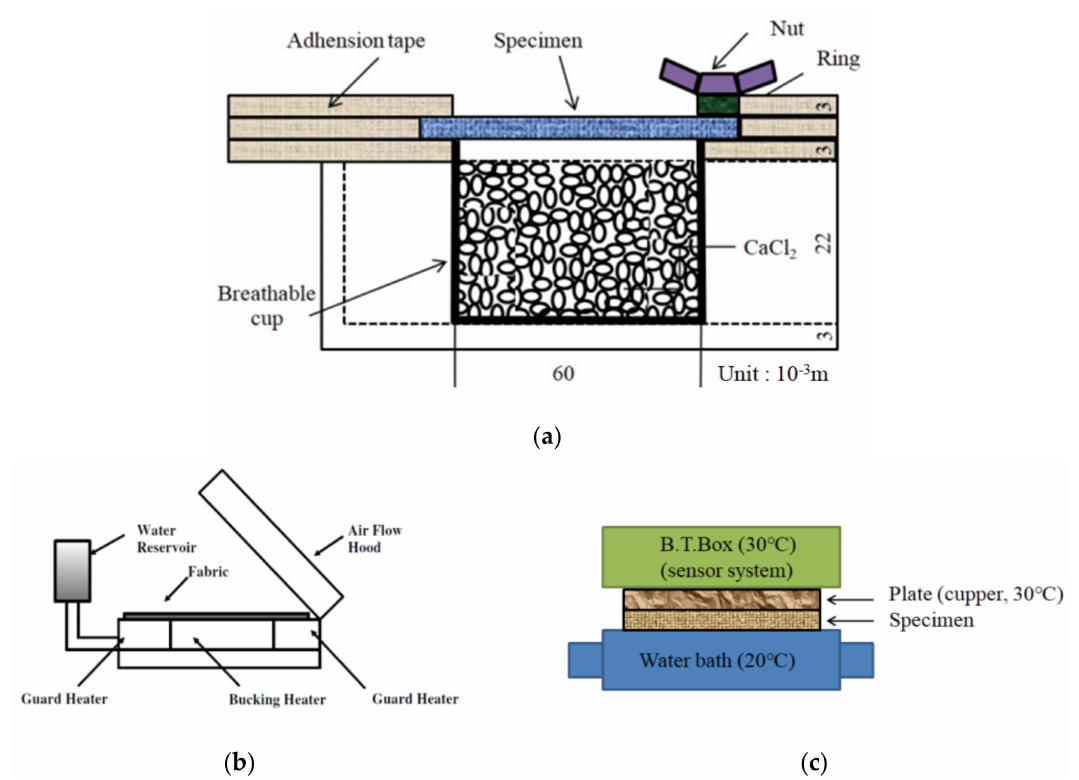
Figure 2. Schematic diagram of the measuring equipment of ( a ) upright cup method (JIS L 1099A-1), ( b ) sweating guarded hot plate method (ISO 11092), and ( c ) KES-F7 system